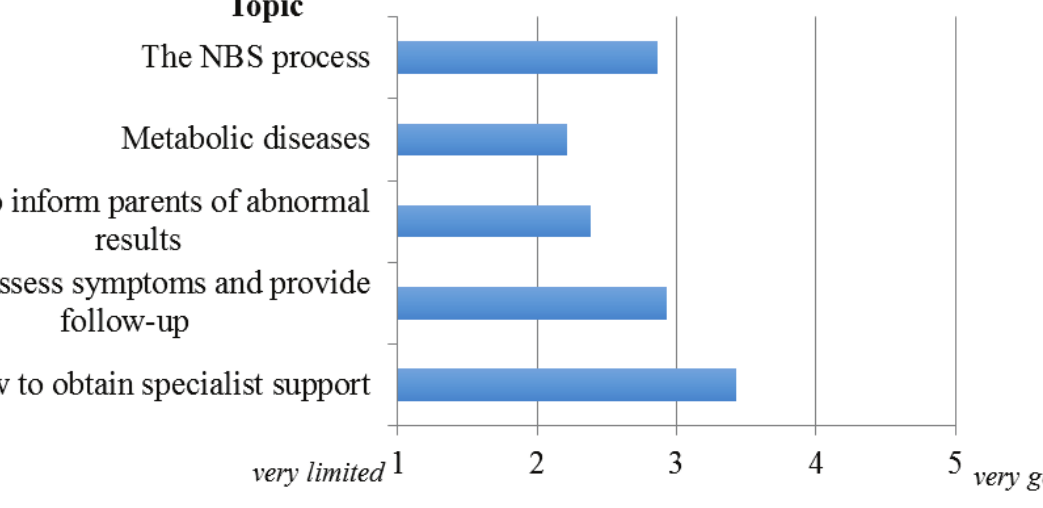
Figure 1. Perceived knowledge-base of